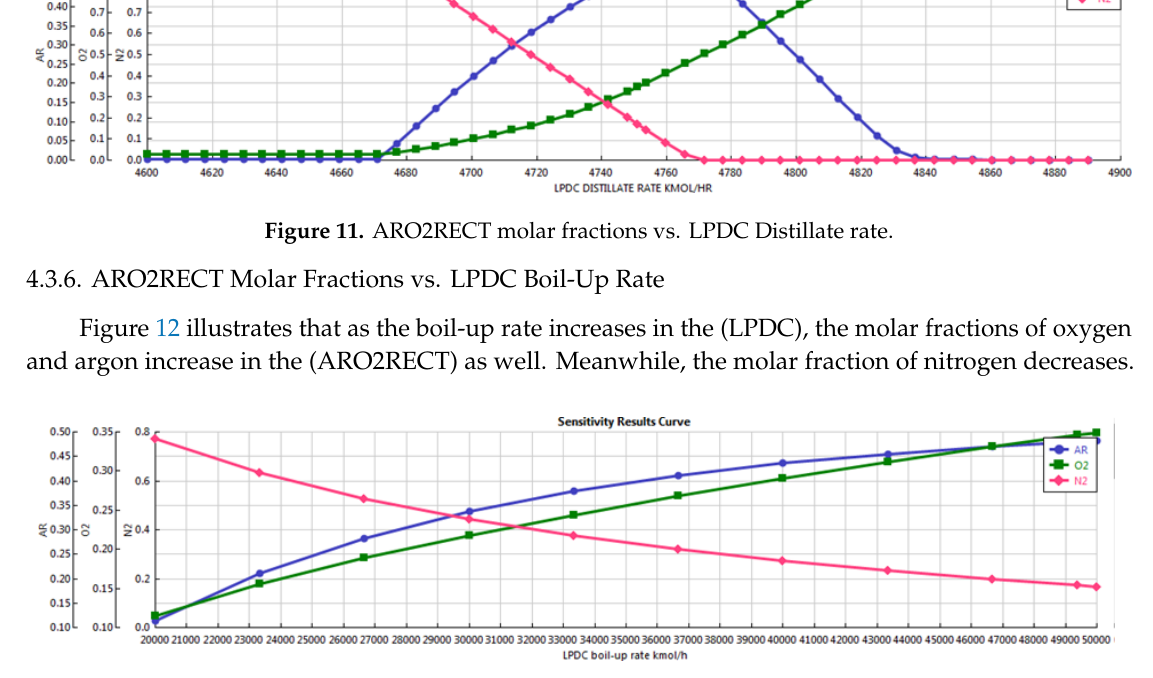
Figure 12. ARO2RECT molar fractions vs. LPDC Boil-up rate.